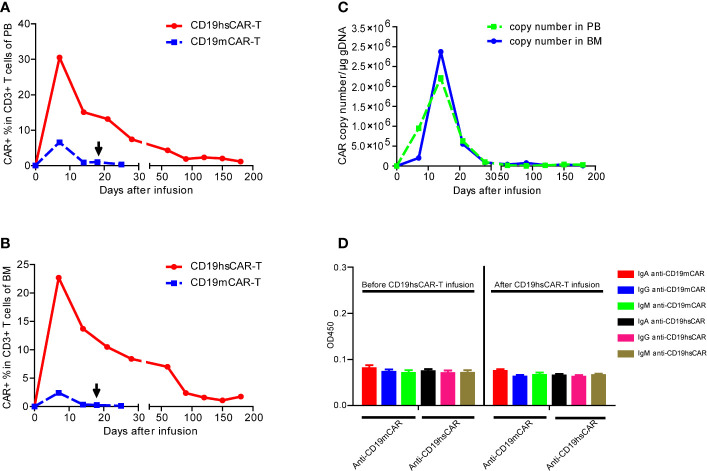
The expansion and persistence of CD19hsCAR-T in patient, and the anti-CAR immunoglobulins in the patient serum. (A, B) Expansion of CD19hsCAR-T (red dot solid line) and CD19mCAR-T (blue square dashed line) in PB and BM after infusion. The arrows indicate the time of the second infusion of CD19mCAR-T. (C) CD19hsCAR copy number in PB and BM was measured by using qPCR before and after infusion. PB, peripheral blood; BM, bone marrow. (D) Anti-CAR immunoglobulins, including IgA, IgG and IgM were examined before and after CD19 hsCAR-T infusion. The serum samples were collected at day 0 before and day 30 after CD19 hsCAR-T infusion. The data were presented as mean ± SE (n=3).